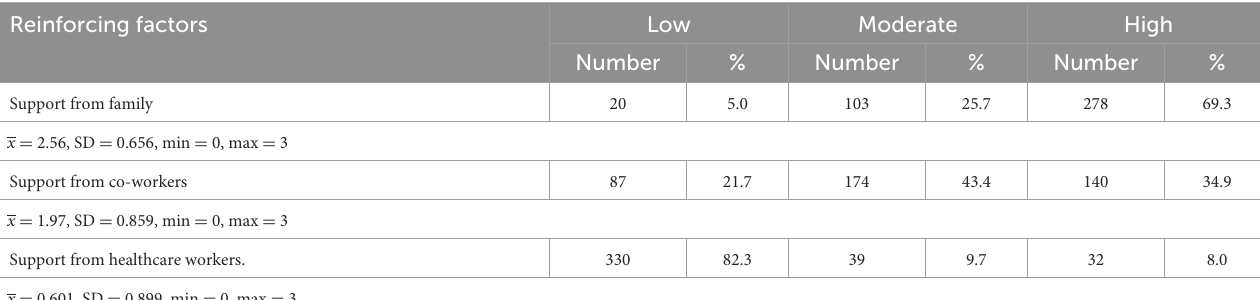
Table 6. A stepwise multiple regression analysis was used to predict taxi drivers’ COVID-19 preventive behaviors. Seven factors were used to predict taxi drivers’ COVID-19 prevention